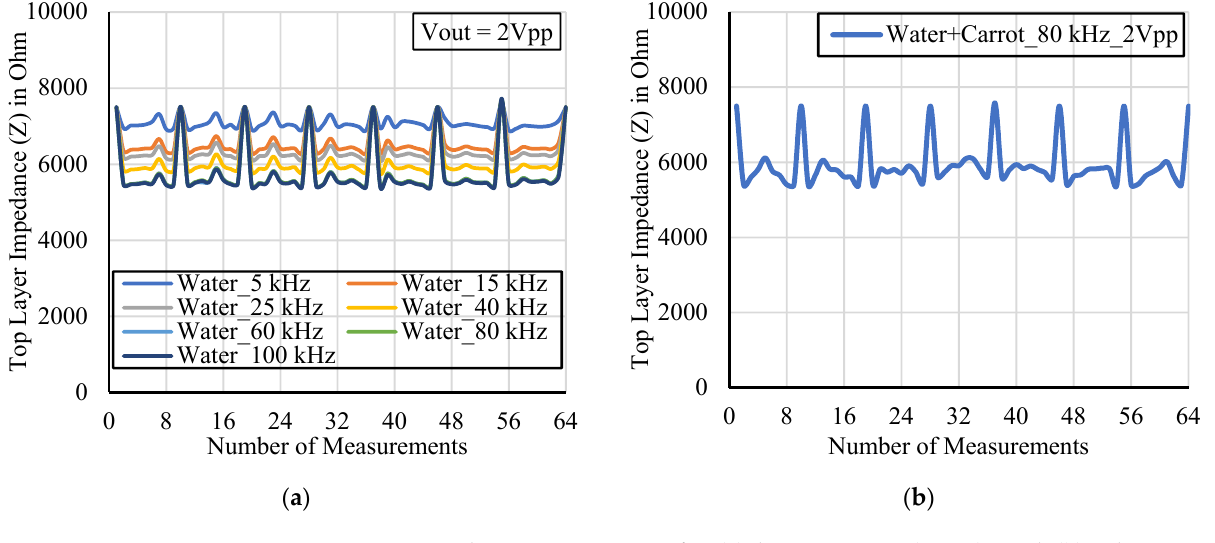
Figure 15. Impedance spectroscopy for ( a ) homogeneous (water), and ( b ) inhomogeneous (water + carrot) media in the top layer of the cylindrical domain at 2 Vpp output excitation. Impedance is decreased in different electrodes position by increasing frequency.